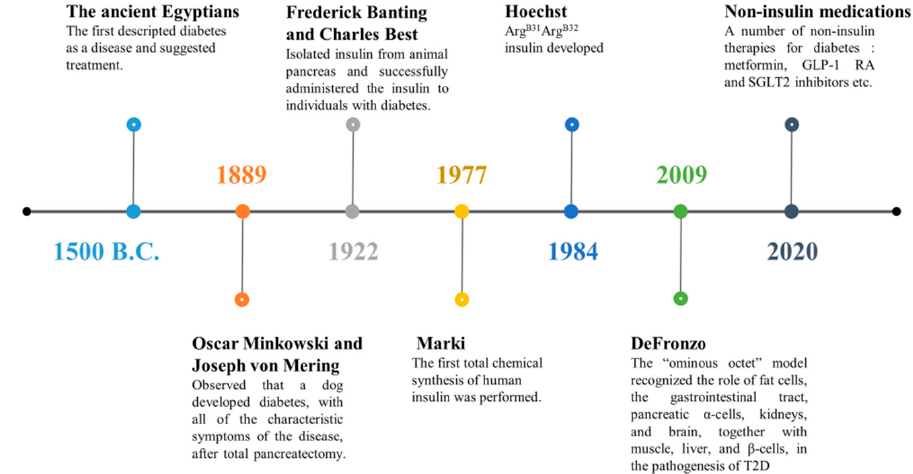
Figure 1. A timeline highlighting represents the development of insulin and T2DM as a therapeutic agent for the treatment of diabetes and the development of modified insulin products with more prolonged times of